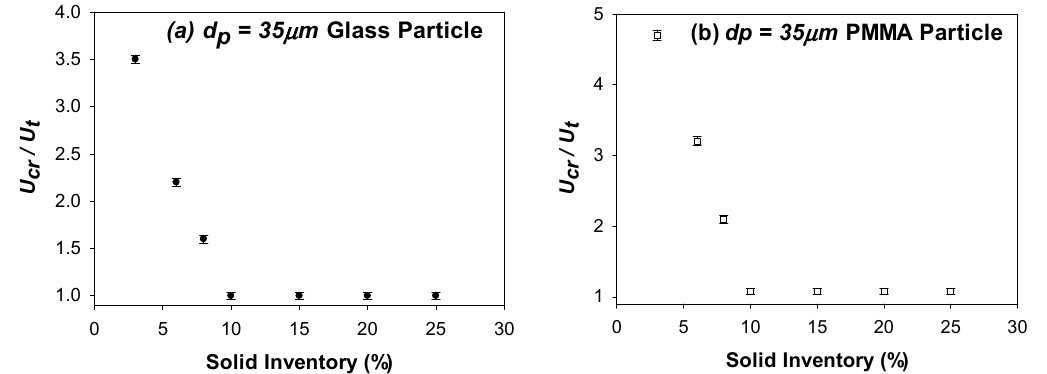
Figure 11. Solid inventory influence on the normalised transition velocity, U cr / U t , for 35 µ m ( a ) glass and ( b ) PMMA particles.